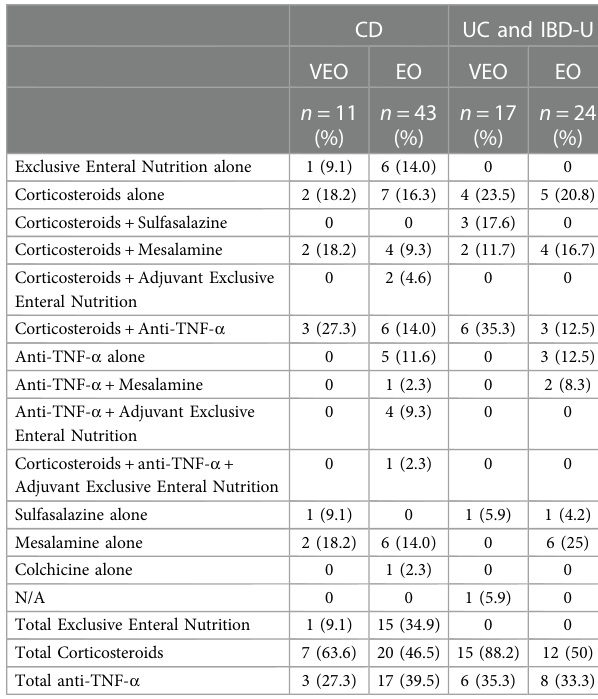
TABLE 3 Induction